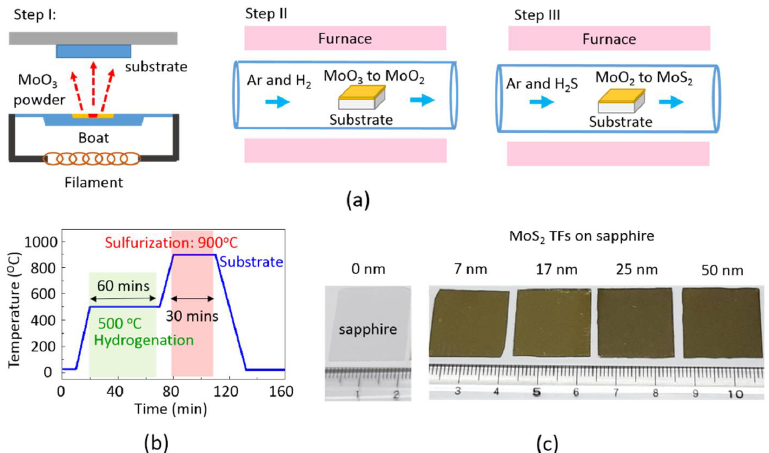
Figure 1. ( a ) Schematic diagram of the MoS 2 TFs synthesis process. ( b ) The temperature profile for the MoS 2 TFs growth process at different stages. ( c ) From left to right: the photographs of the substrate before and after MoS 2 TFs growth with thicknesses varying from 0 to 50 nm.